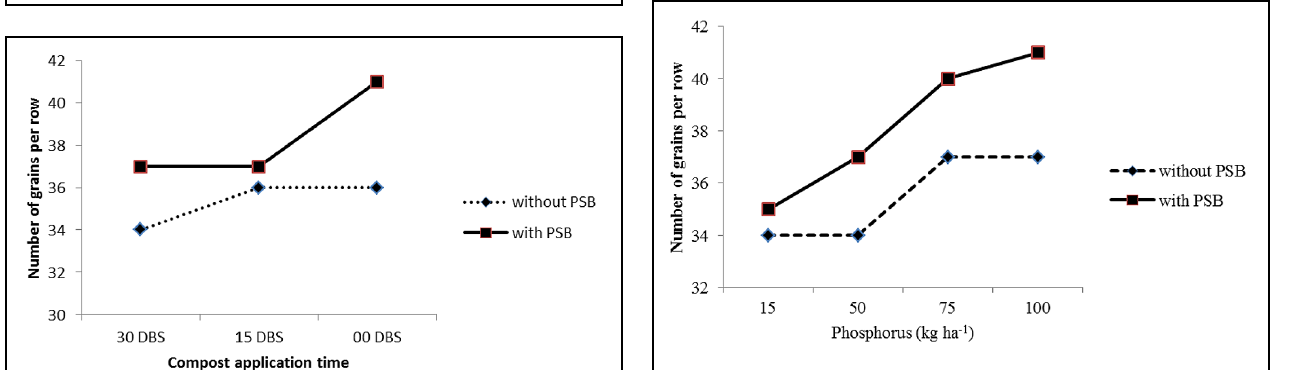
FIGURE 2 | Response of number of grain yield (kg/ha) of maize ( Zea mays L.) to phosphorus levels (P) and compost application time (C) interaction (P × C).